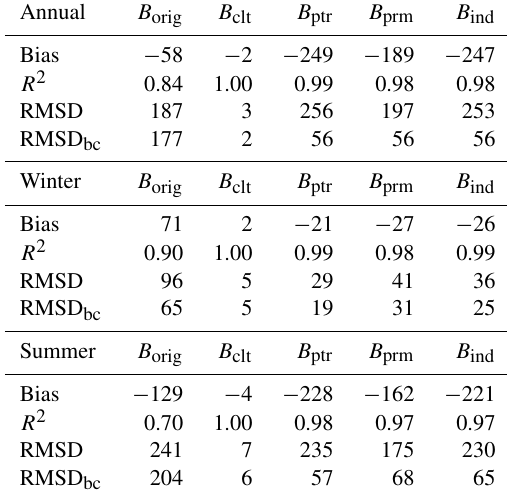
Table 2. Statistical evaluation of mass balance series based on dif- ferent extrapolation methods compared to the reference method: bias, R 2 and root mean square deviation before (RMSD) and after (RMSD bc ) a bias correction of the